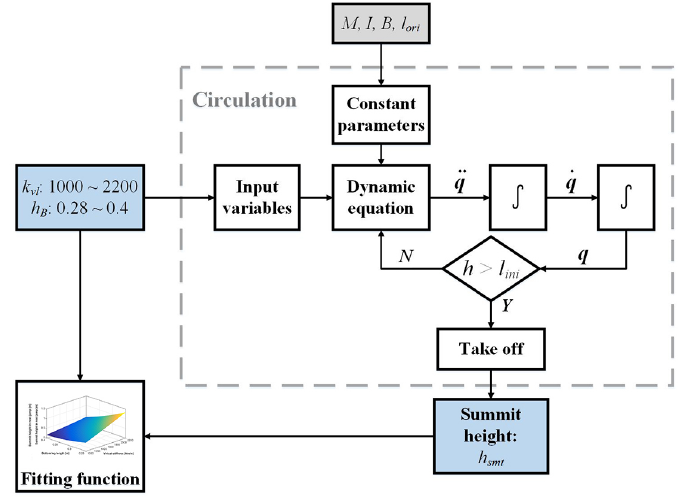
Figure 7. Framework for simulation and fitting relation between takeoff stiffness, bottom height, and final jumping